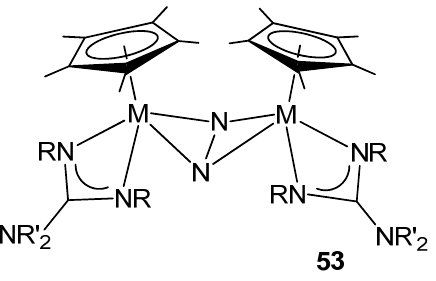
Figure 31. Coordination and activation of dinitrogen with group 4 guanidinato complexes.